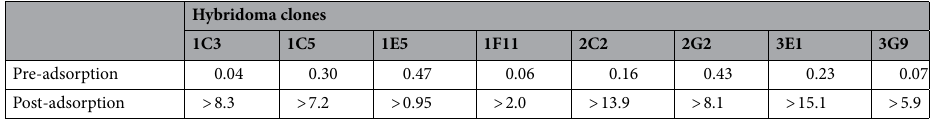
Table 2. The NT 50 values from the pre-adsorption and post-adsorption assays. Average of two independent neutralization tests is shown (μg/ml).